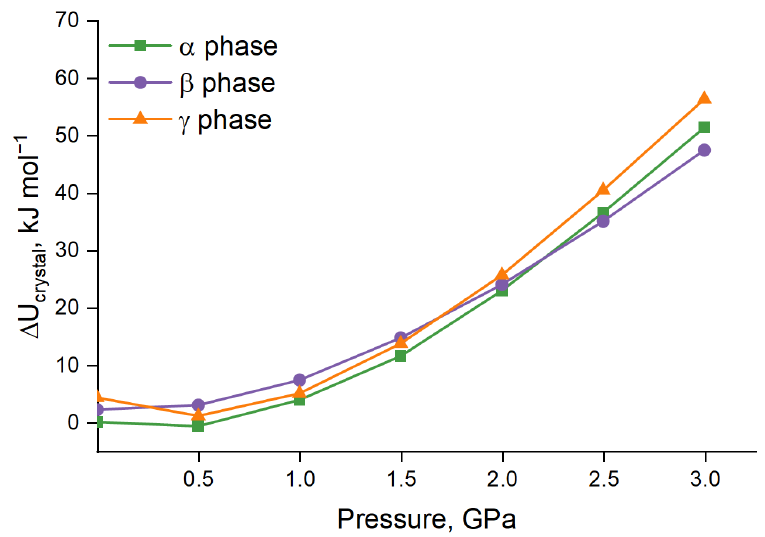
Figure 4. Relative lattice energies of phases α , β , and γ as a function of pressure calculated based on EoS predicted data. Full electronic structure energy contains both inter and intramolecular interaction energies. The α phase energy at ambient pressure is taken as zero.